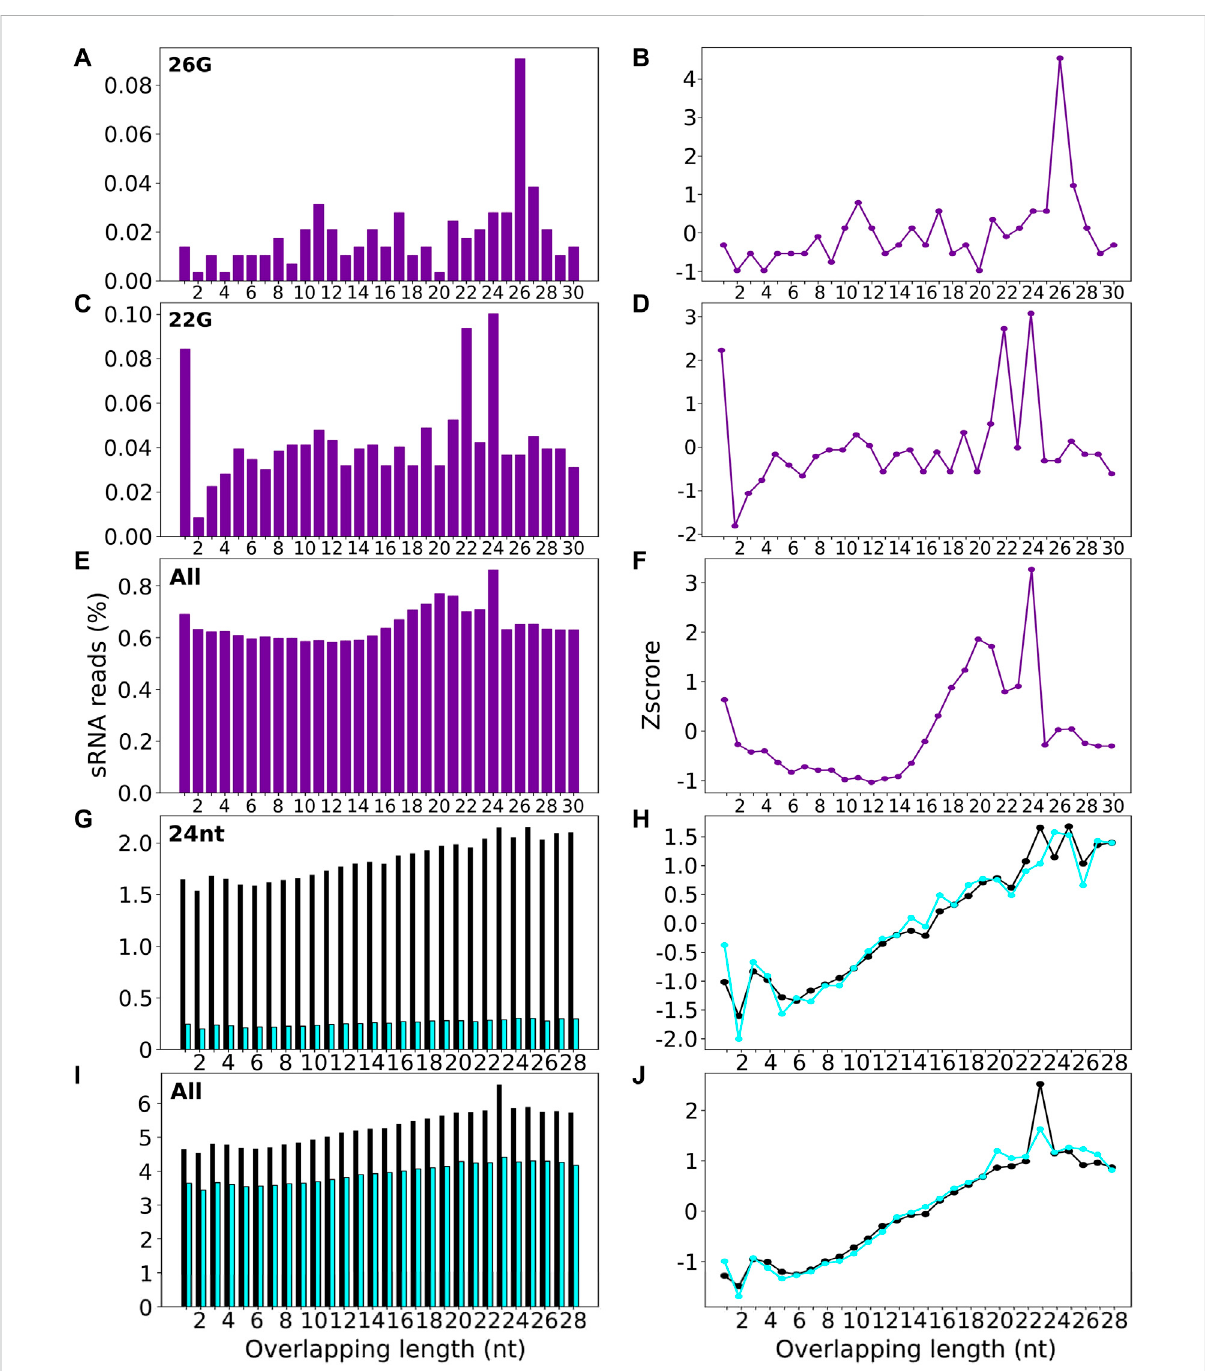
FIGURE 6 Signature.py detects low percentage of overlapping sRNA sequences inrealdatasets.signature.pywasrun on26G sRNAs (A andB) ,22G sRNAs (C and D) and all sRNAs (E and F) for C. elegans, and 24 nt sRNAs (G and H) (purple), and all sRNAs (I and J) for WT (black) and dcl2dcl3dcl4 mutant cell lines (blue) for A. thaliana. Output barplots (left) show the length of overlapping sequence identi fi ed for sRNAs aligned in a potential duplex. Lineplots (right) show the enrichment z-score for the overlapping lengths shown in the